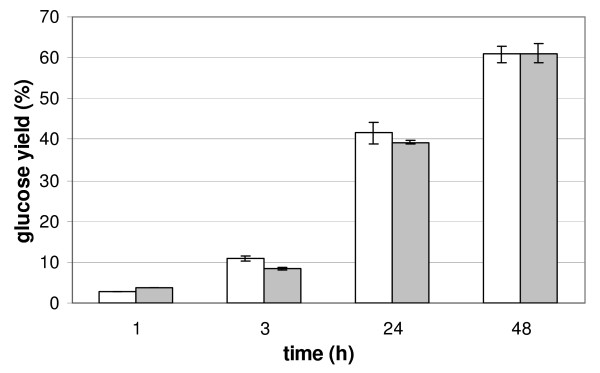
Hydrolysis yields of steam-exploded wheat straw with T. reesei enzymes. Hydrolysis was performed either with the complete T. reesei enzyme cocktail K630 (white bars), or the reconstituted cocktail (grey bars) composed of the six purified enzymes (CBH1 44%, CBH2 30%, EG17.3%, EG2 14.2%, Cel74a 0.5%, XYN1 4%). Substrate loading was 1% DM and enzymes were added at 2.5 mg/g substrate. DM, dry matter.